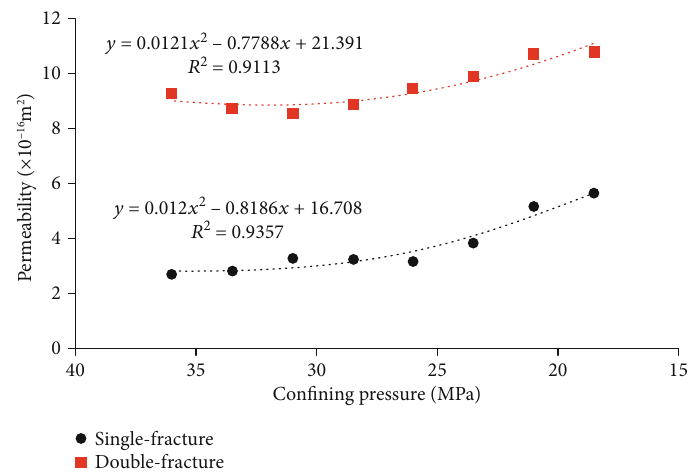
Figure 6: Permeability evolution of fractured sandstones under di ff erent con fi ning